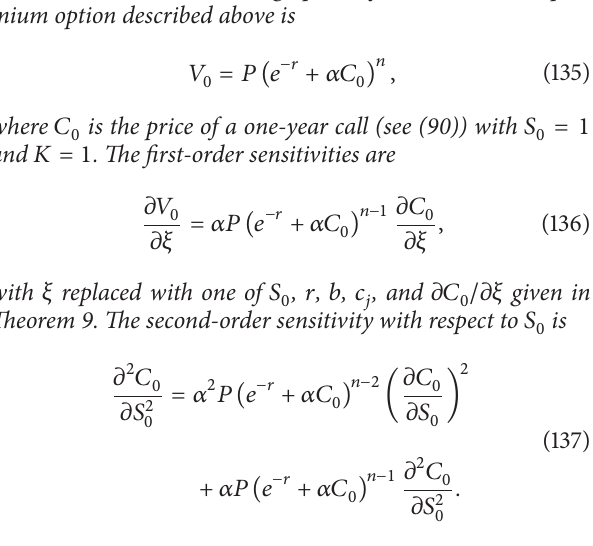
and the minimum at (−0.0836, 0.163)